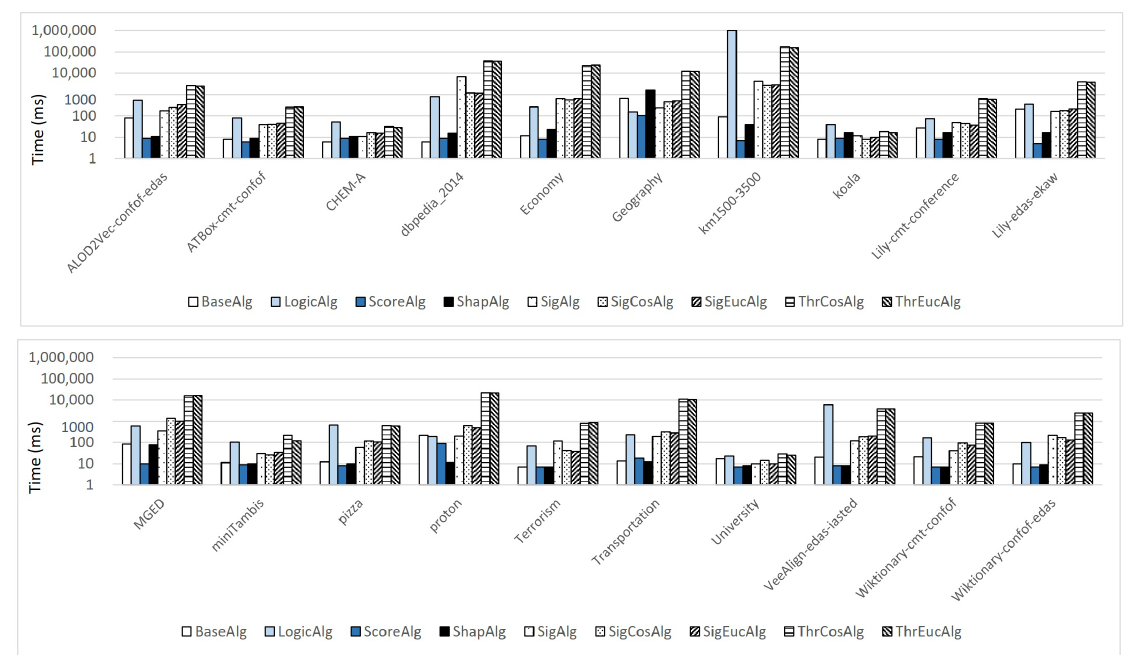
Figure 4. Time in milliseconds (y-axis) for each incoherent ontology to compute diagnoses using the model m1 and the threshold